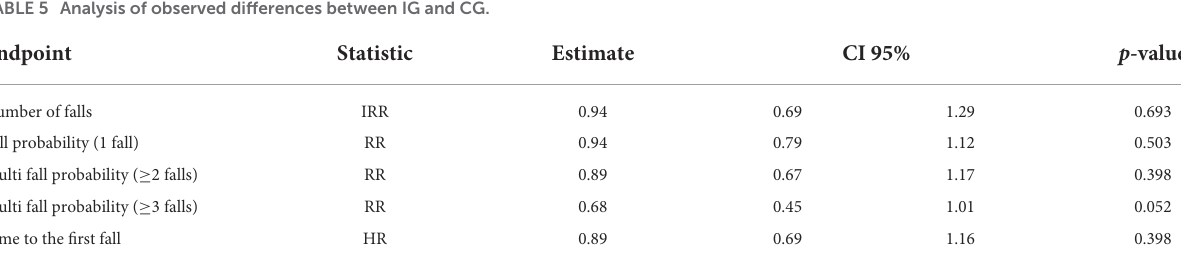
TABLE 5 Analysis of observed differences between IG and